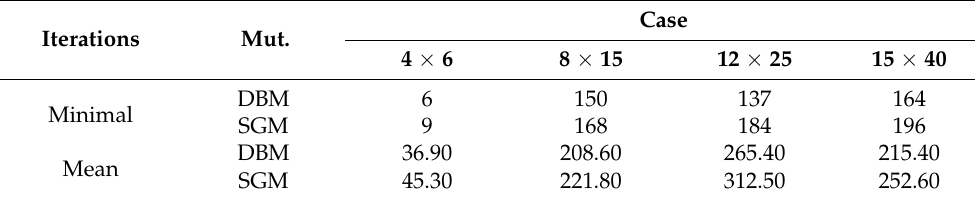
Table 8. Comparative iterations of the convergence experiments.